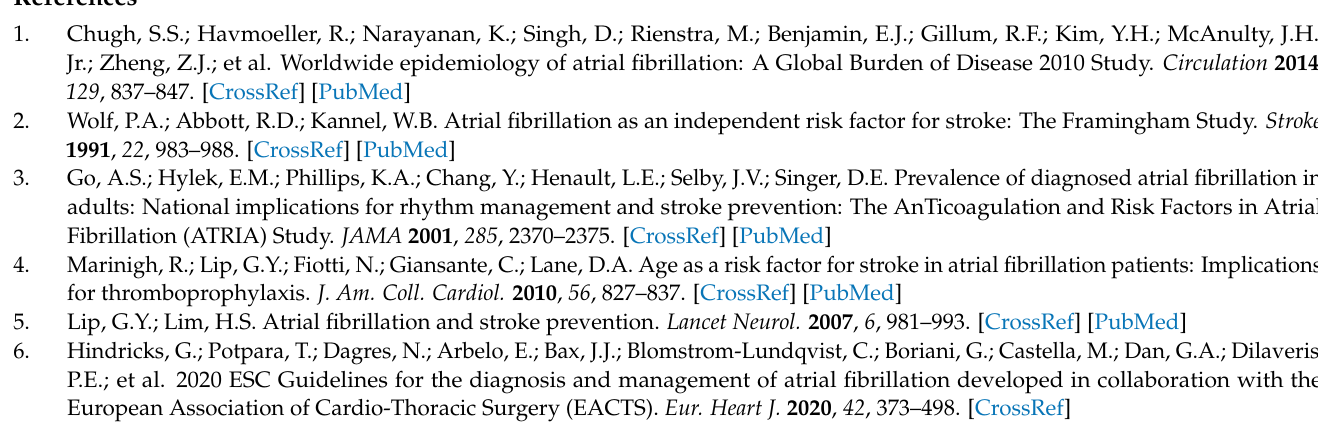
Figure S1: Funnel Plot of Studies Pooled for In-hospital Mortality; Figure S2: Funnel Plot of Studies Pooled for Pericardial Effusion/Tamponade; Figure S3: Funnel Plot of Studies Pooled for Major Bleeding Events; Table S1: Clinical Outcomes; Table S2: The Risk of Bias Assessment tool for Non- randomized Studies (RoBANS); Table S3: Sensitivity